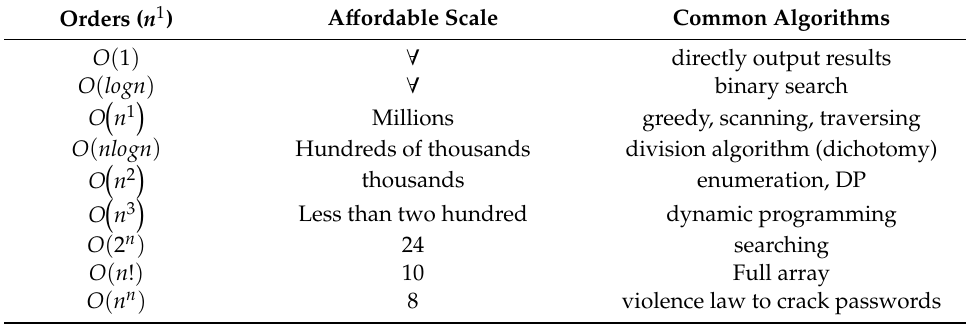
Table 1. Time complexity of common